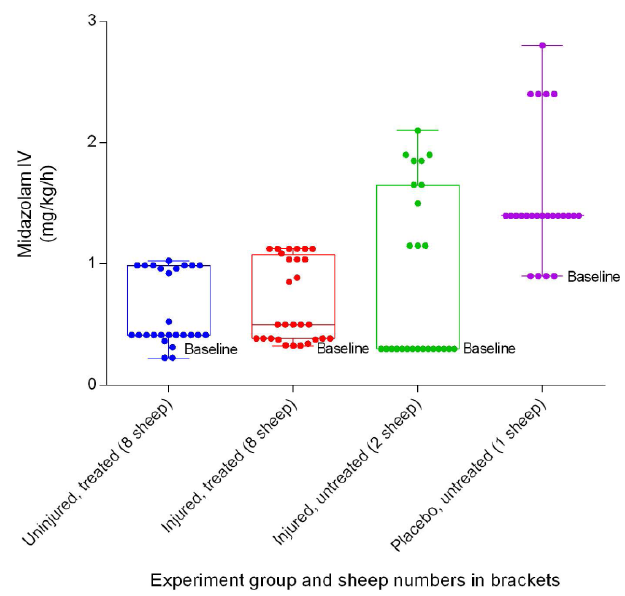
Figure 43. Midazolam IV infusion (Mean ± SD) indicating the titration range in smoke and non-smoke injured sheep receiving extracorporeal life support as compared to that in untreated controls over a 24-hour period.